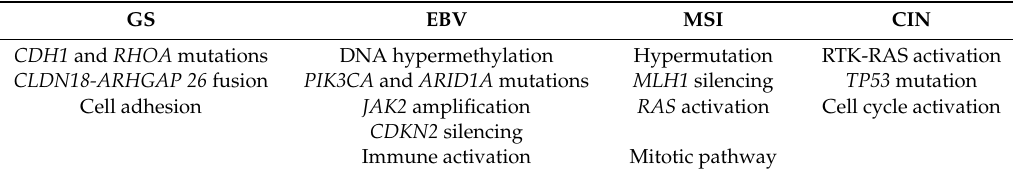
Table 1. Molecular features of GEA subgroups of TCGA